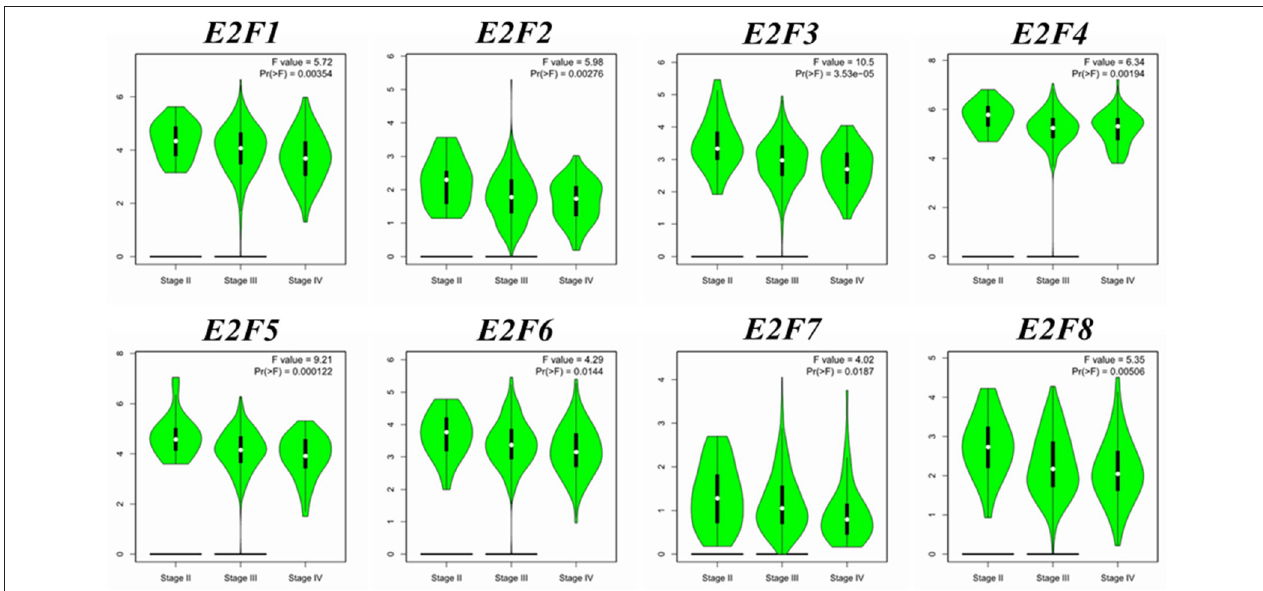
FIGURE 3 | Correlation between E2F expression and tumor stage in OC patients (GEPIA). Violin plot derived from correlation between the expression of a specific E2F family member and tumor stage in patients with OC; the p -value was set at 0.05. The distribution of E2F1 , E2F2 , E2F3 , E2F4 , E2F5 , E2F6 , E2F7 , and E2F8 mRNA expression correlated with tumor